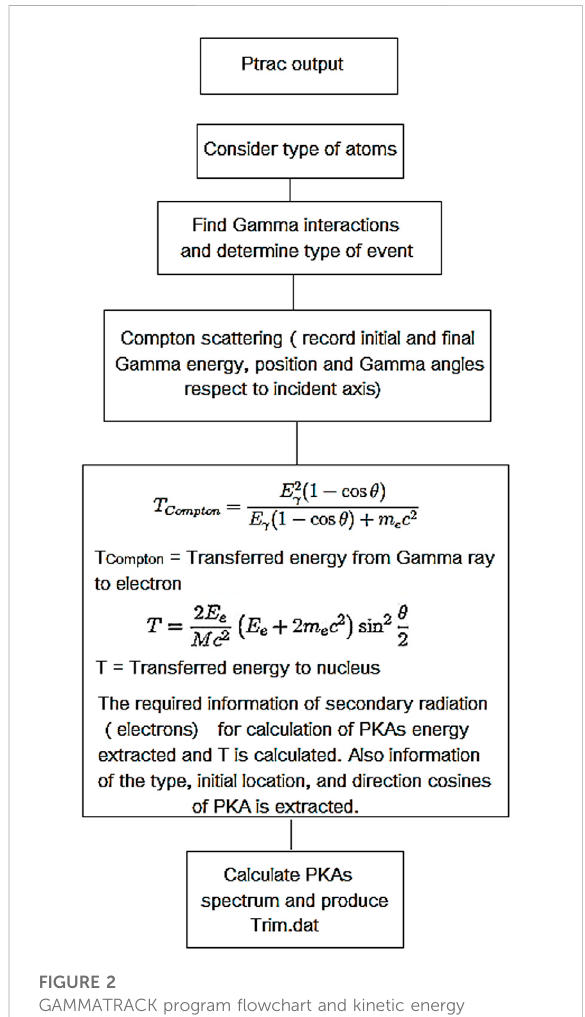
FIGURE 2 GAMMATRACK program fl owchart and kinetic energy